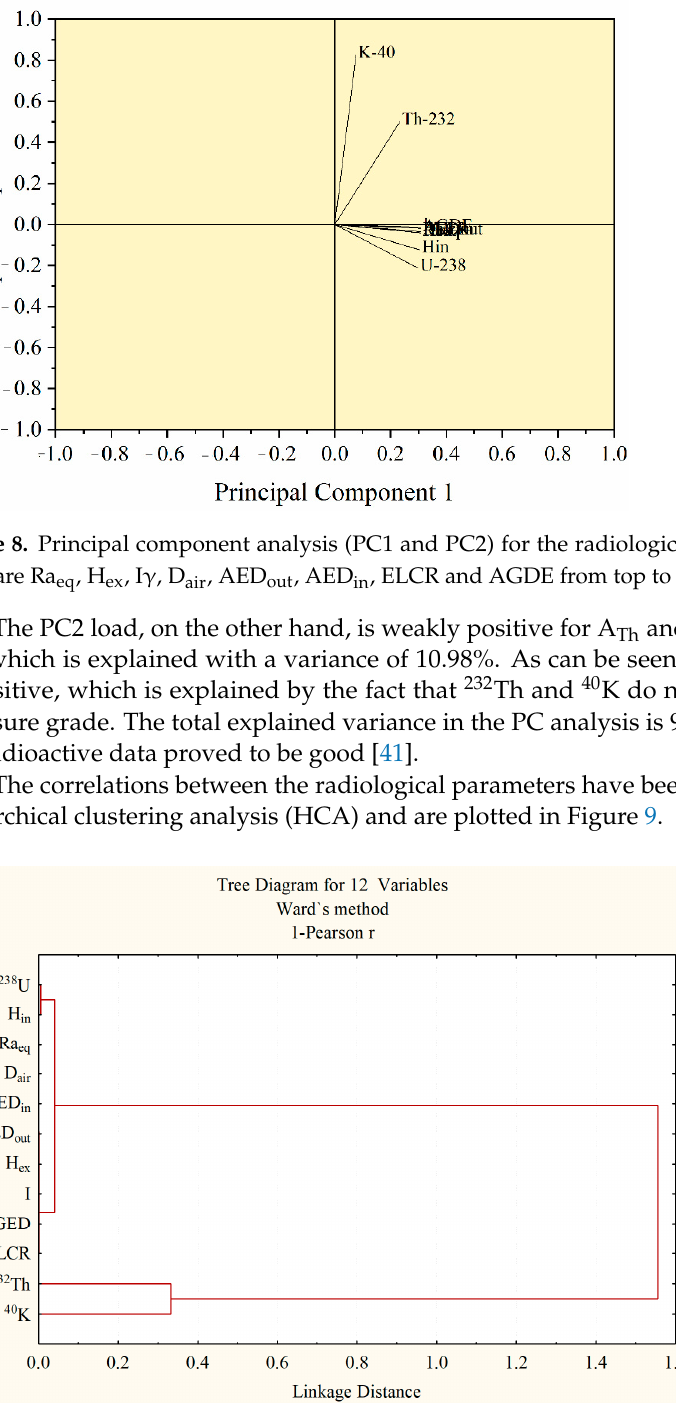
The PCA (principal component analysis) used varimax rotations in order to control the correlation matrix between several items. In Figure 8, the PC1 and PC2 components are provided and plotted. The A U is highly positive in the PC1 loading, correlating with all of the radioactive variables, and is explained with a variance of 87.83%. This indicates that the A U is the primary source of the natural radioactivity in the granitic rocks studied here.